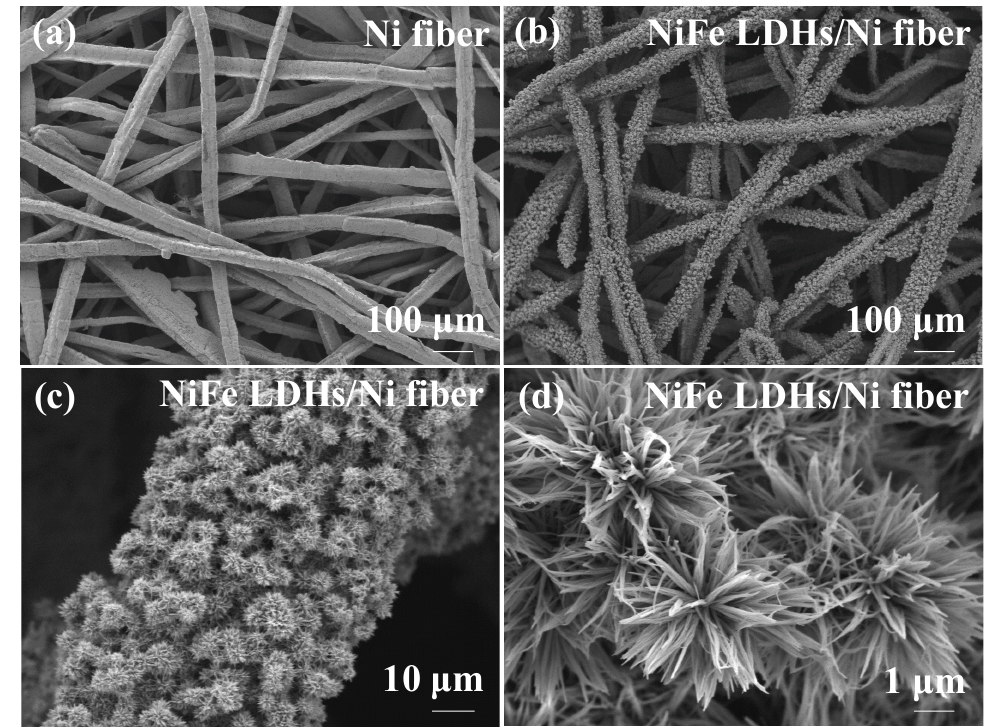
Figure 2. SEM images of Ni fiber electrode, ( a ) and NiFe LDHs/Ni fiber electrode ( b – d ).